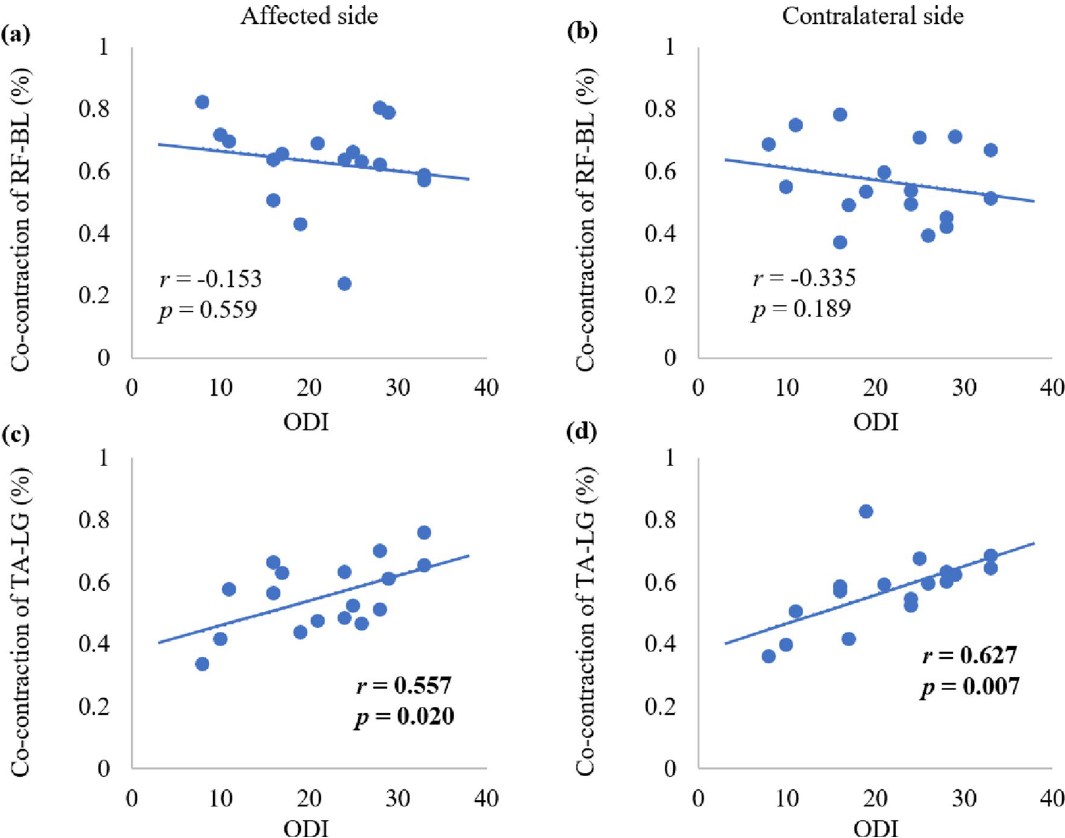
Figure 6. The relationship between muscle co-contraction and Oswestry disability index (ODI) scores in lumbar disc herniation (LDH)